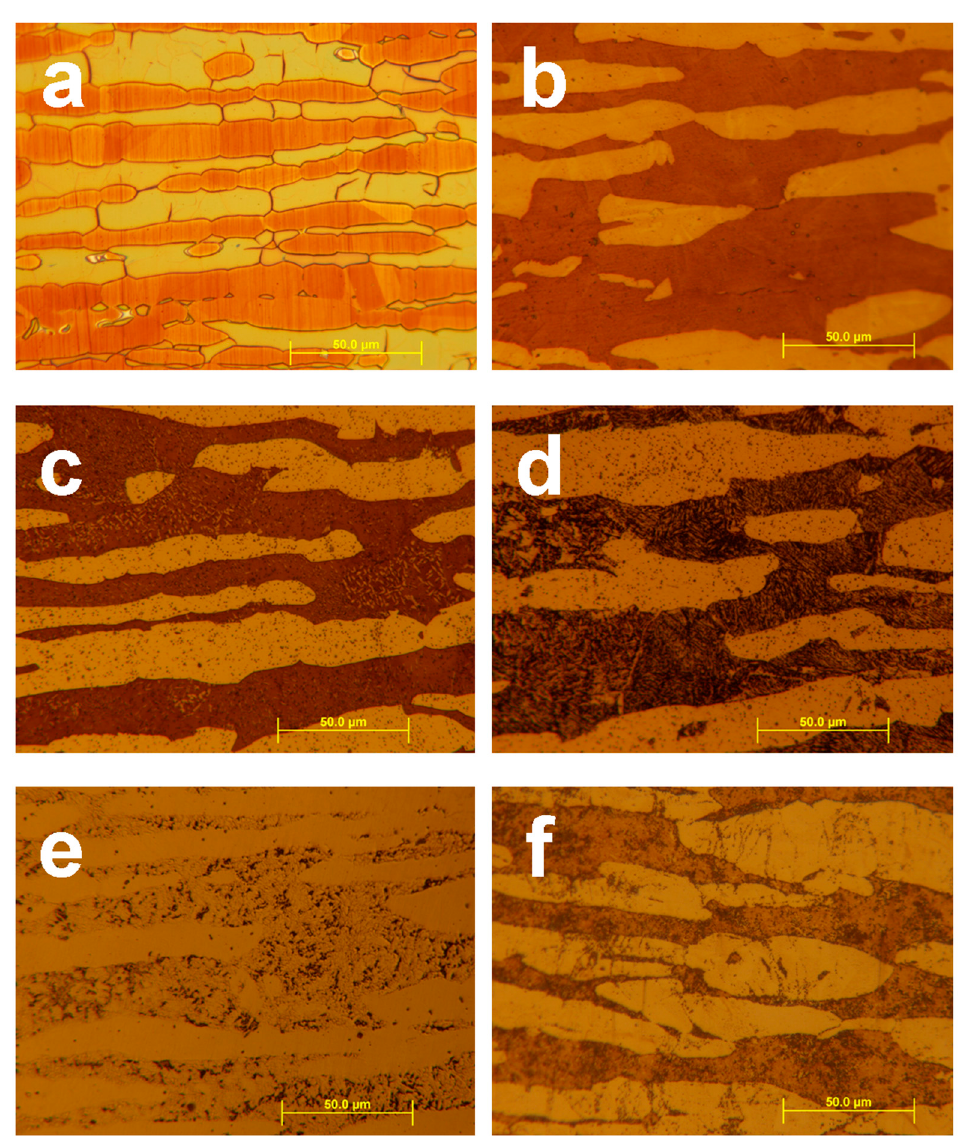
Figure 3. Optical micrographs:( a ) without deformation, using Beraha II reagent,( b ) without deformation, using Murakami’s reagent,( c ) 60% rate of cold working with Beraha II reagent,( d ) 60% rate of cold working and heat treatment at 500 °C with Beraha II reagent,( e ) 60% rate of cold working and heat treatment at 800 °C with Beraha II reagent, and( f ) 60% rate of cold working and heat treatment at 800 °C with Murakami’s reagent.